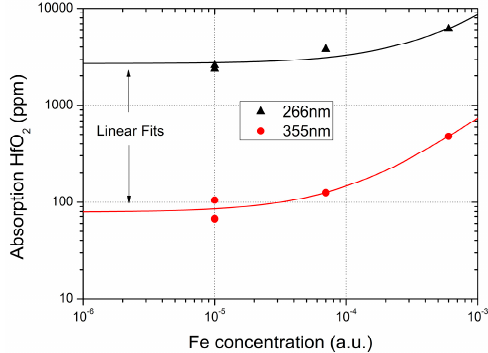
Figure 7. Absorption in HfO 2 single layers as a function of the iron concentration for the wavelengths 266 and 355 nm, respectively.